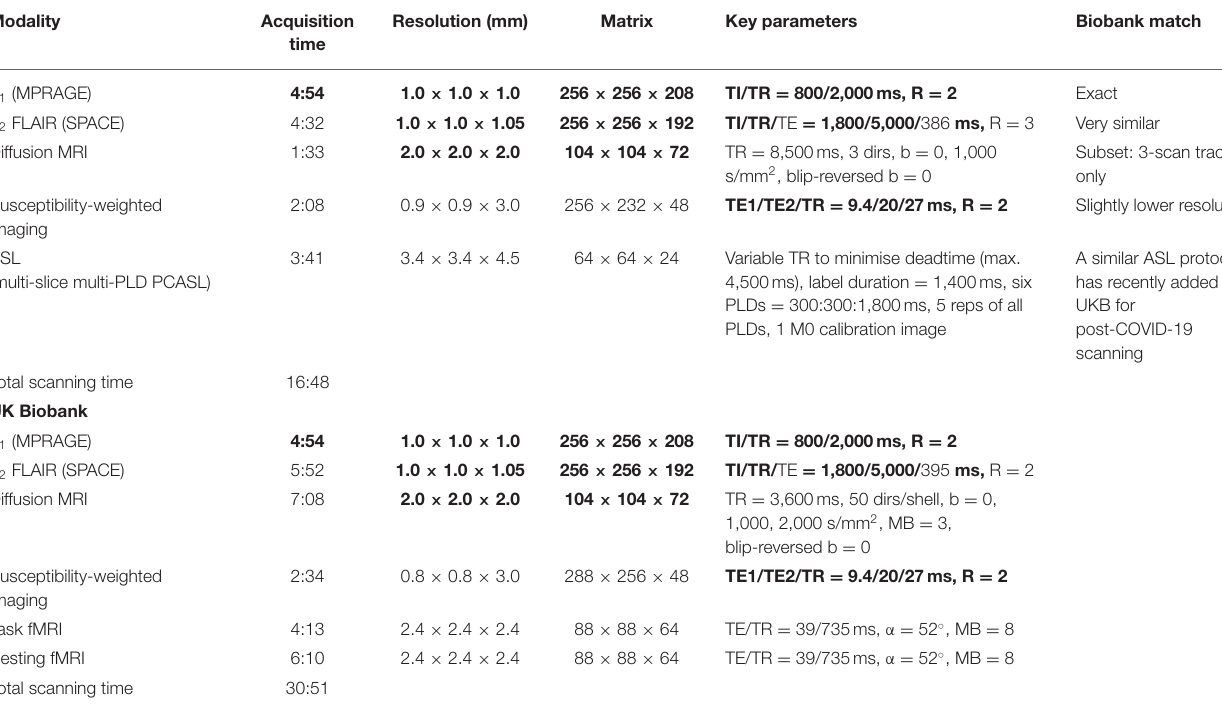
TABLE 1 | Brain MRI sequences of the COVID-19 multiorgan protocol: acquisition details and comparison with UKB protocol. Modality Acquisition Resolution (mm) Matrix Key parameters Biobank time